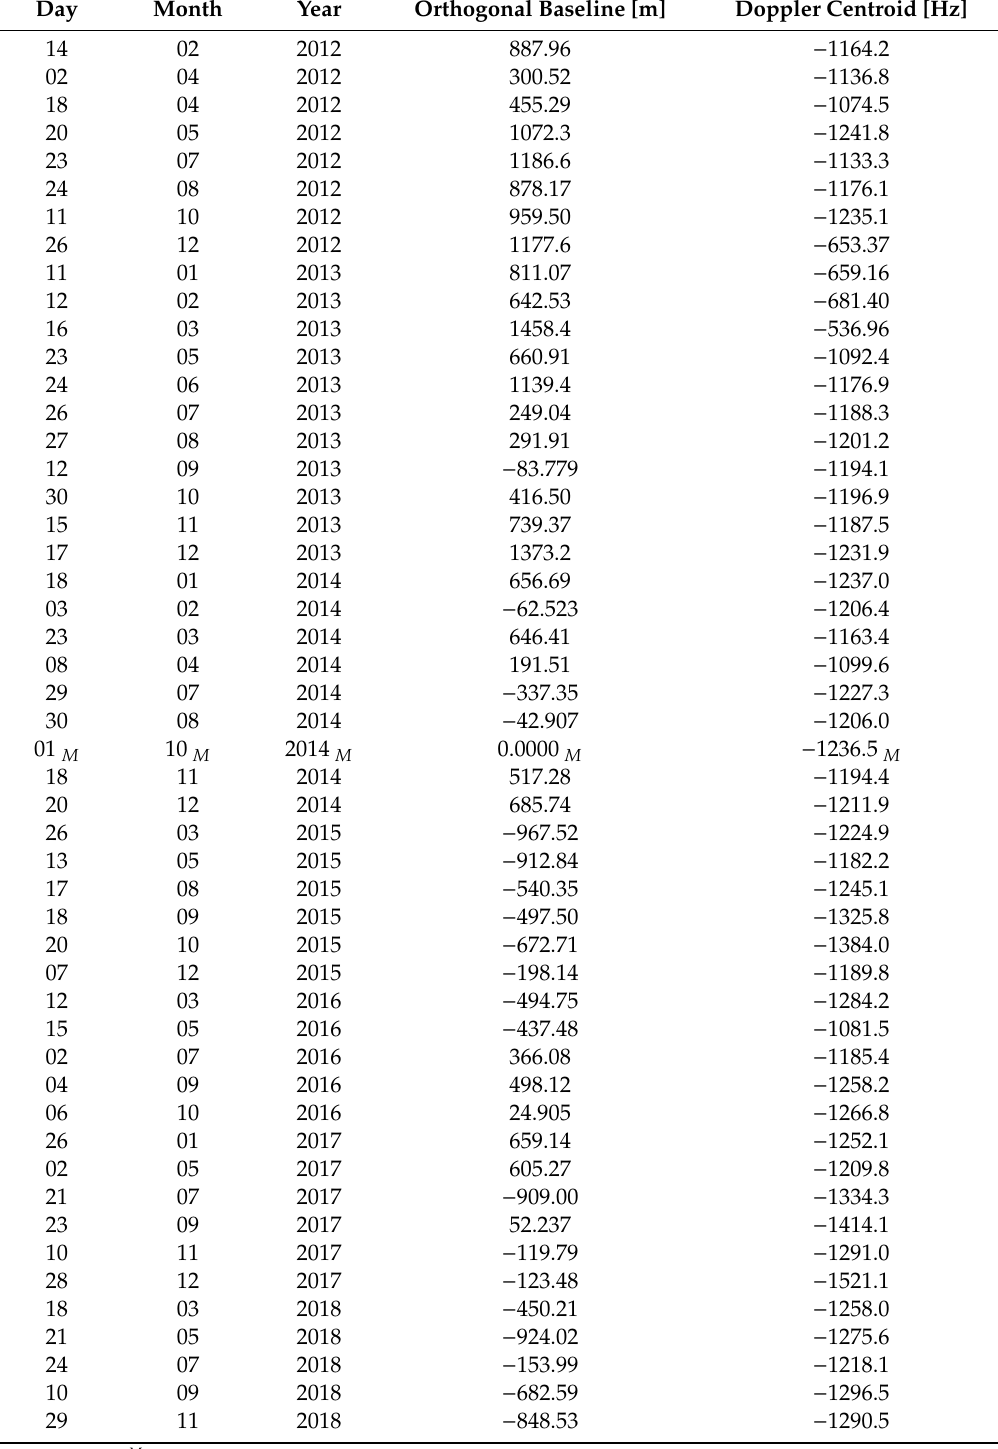
M The footer corresponds to the master acquisition used for the images